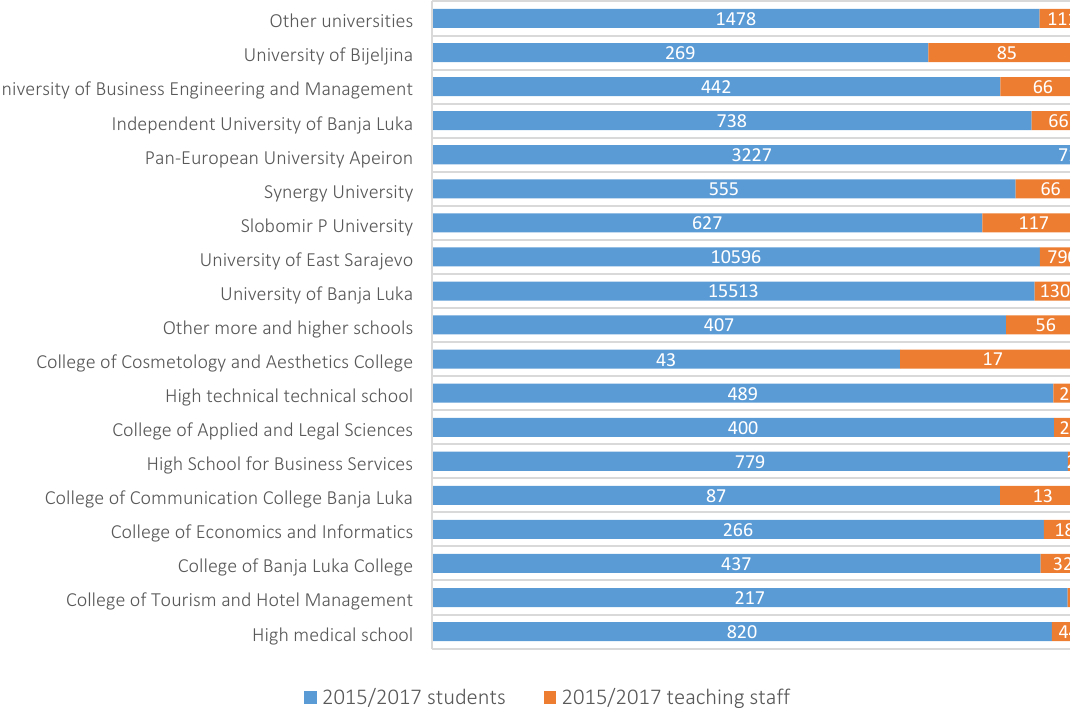
Figure 2. Students and teaching staff in RS